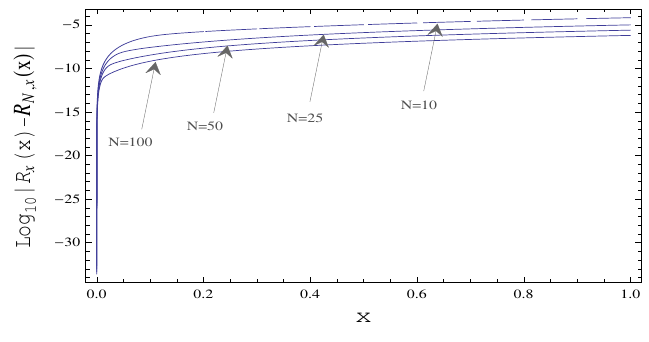
Figure 4. Graph of Log 10 | R x ( x ) − R N,x ( x ) | for Example 2 with N = 10 , 25 , 50 , 100.